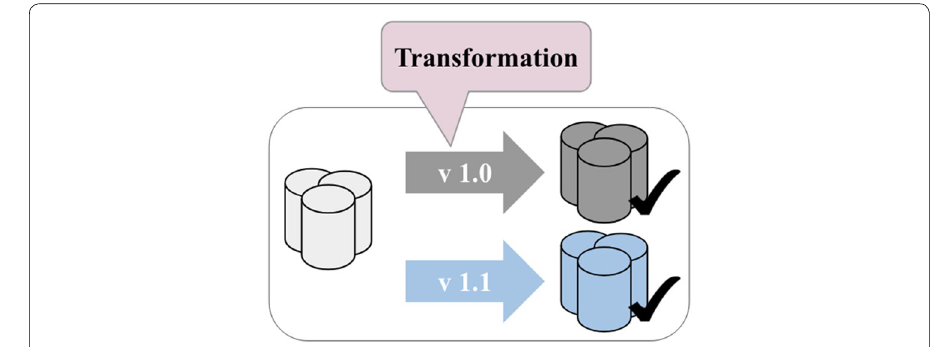
Fig. 1 Validating the outputs of two different versions of a